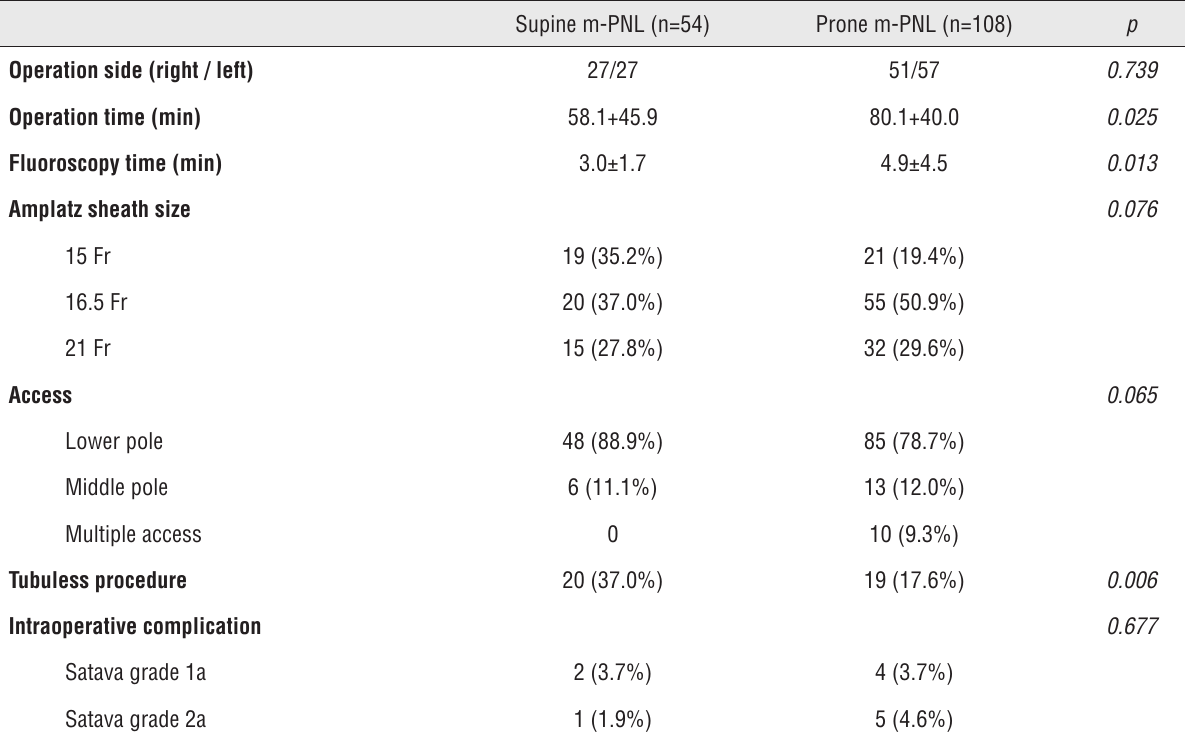
Table 2 - Operative data.